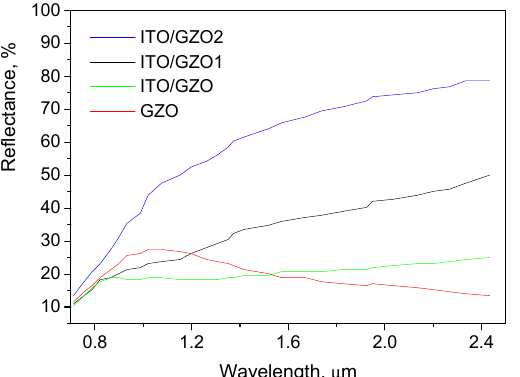
Figure 4. Optical transmittance in the UV-VIS range of single layer of GZO and bi-layer coatings ITO/GZO without and with additional oxidation during sputtering [31].